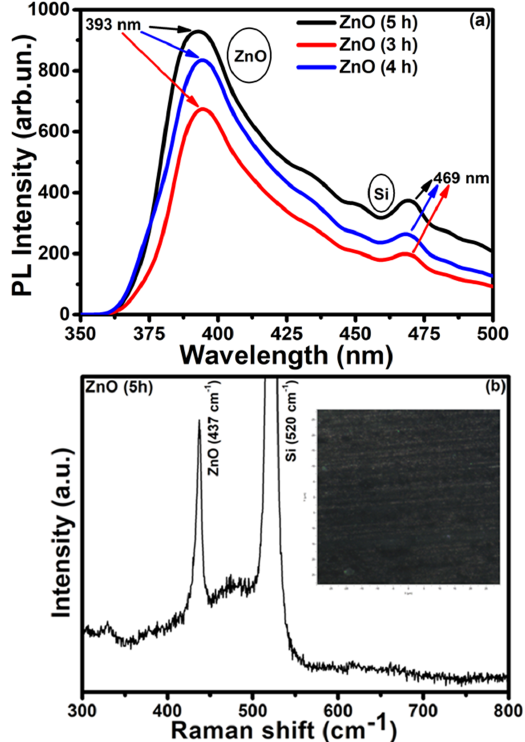
Figure 5. ( a ) Photoluminescence and ( b ) Raman spectrum, with an inset image of ZnO NRs on a Si wafer for 5 h of treatment time. wafer for 5 h of treatment